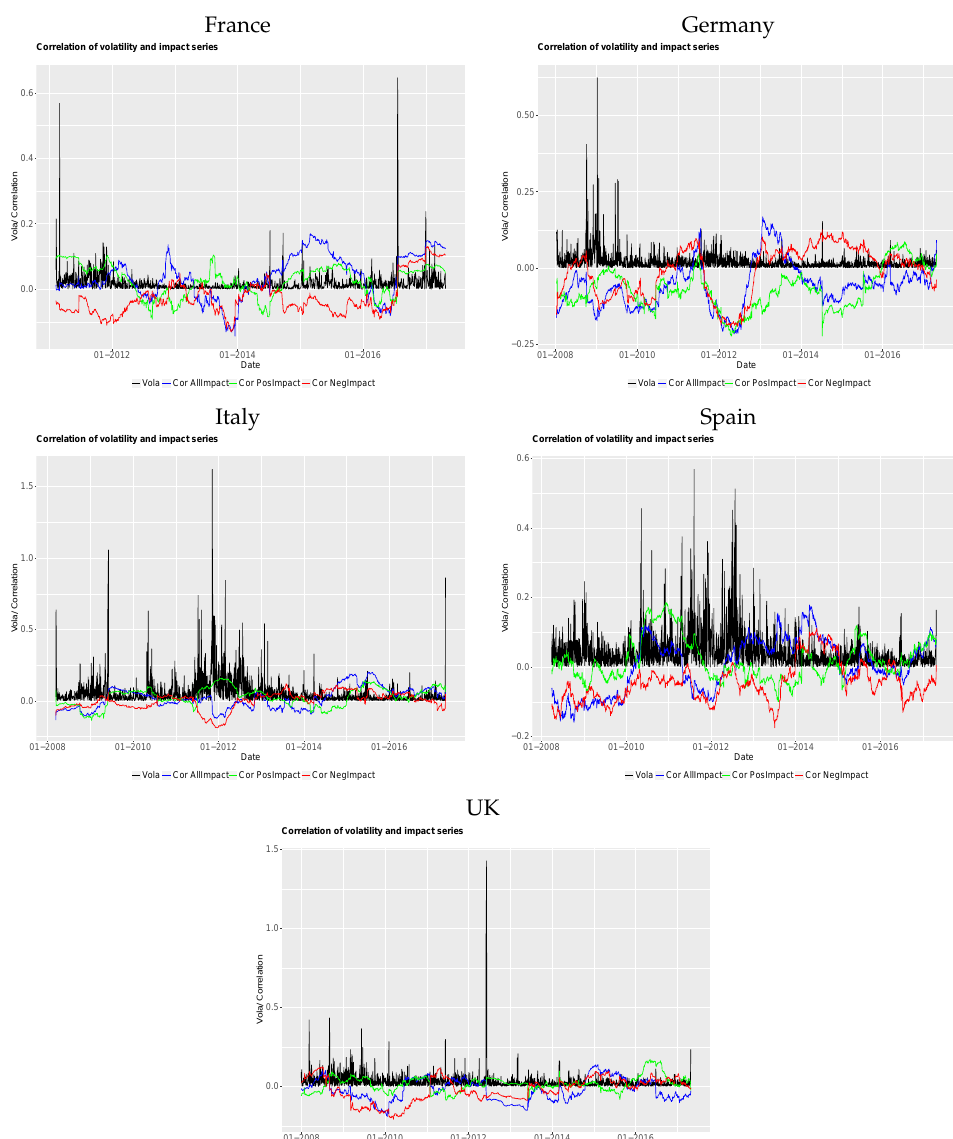
Figure 9. Mean volatility of daily spread change and its correlation with daily news impact series for five European